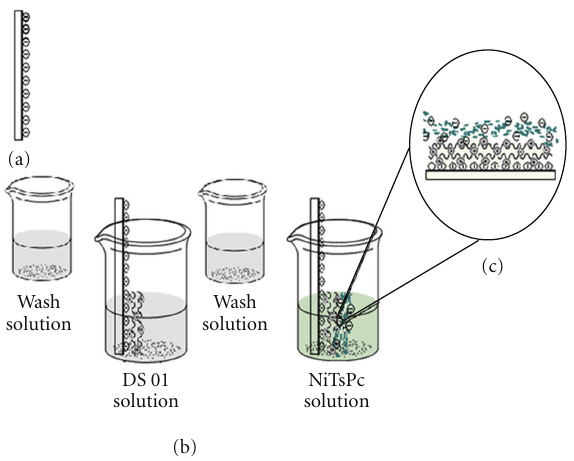
Figure 2: LbL film assembly process: scheme of film formation according to the LbL technique: (a) bare substrate, (b) deposition of the first layer of DS 01 AMP, (c) first bilayer formed (ITO/(DS 01/NiTsPc) 1 ).